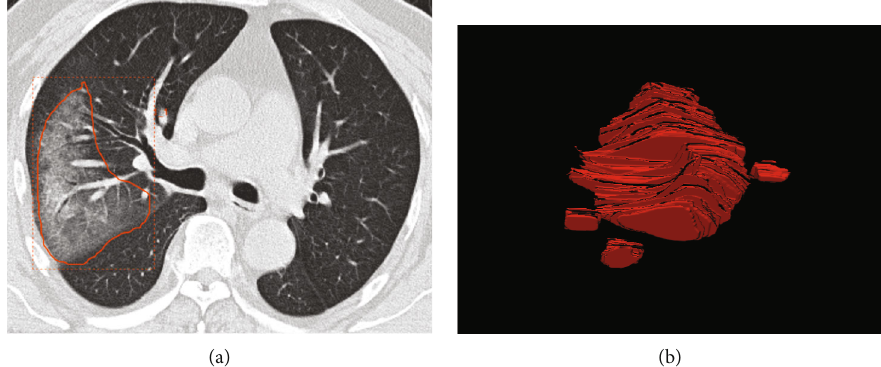
Figure 2: A case of con fi rmed mild COVID-19. A 63-year-old male presented with a 5-day history of fever, cough, and mild dyspnea. (a) CT imaging revealed pure GGO with distribution in the left lower lobe. The area of the lesions was delineated on the axial. (b) The reconstructed images.